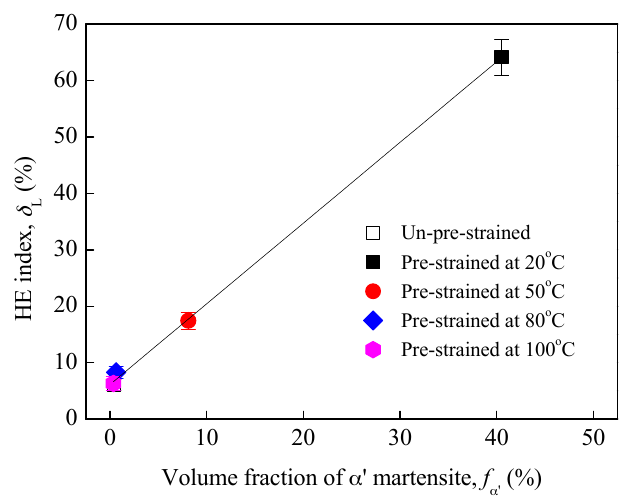
Figure 5. HE index as a function of pre-existing α′ martensite.